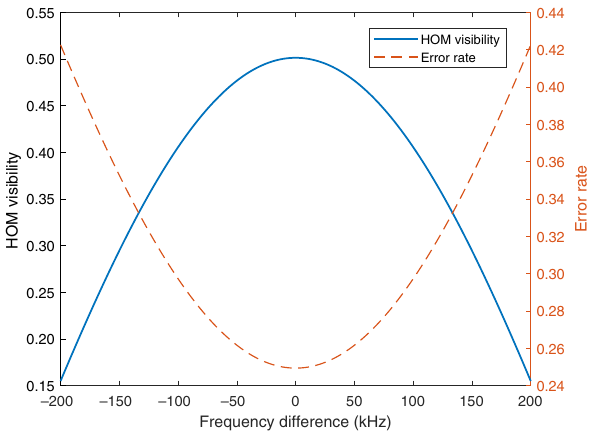
FIG. 4. HOM visibility and the error rate as a function of the frequency difference between two lasers δv . We set the time inter- val of two consecutive time bins τ = 1 μ s. The blue line is the HOM visibility, and the orange dotted line is the interference error rate.